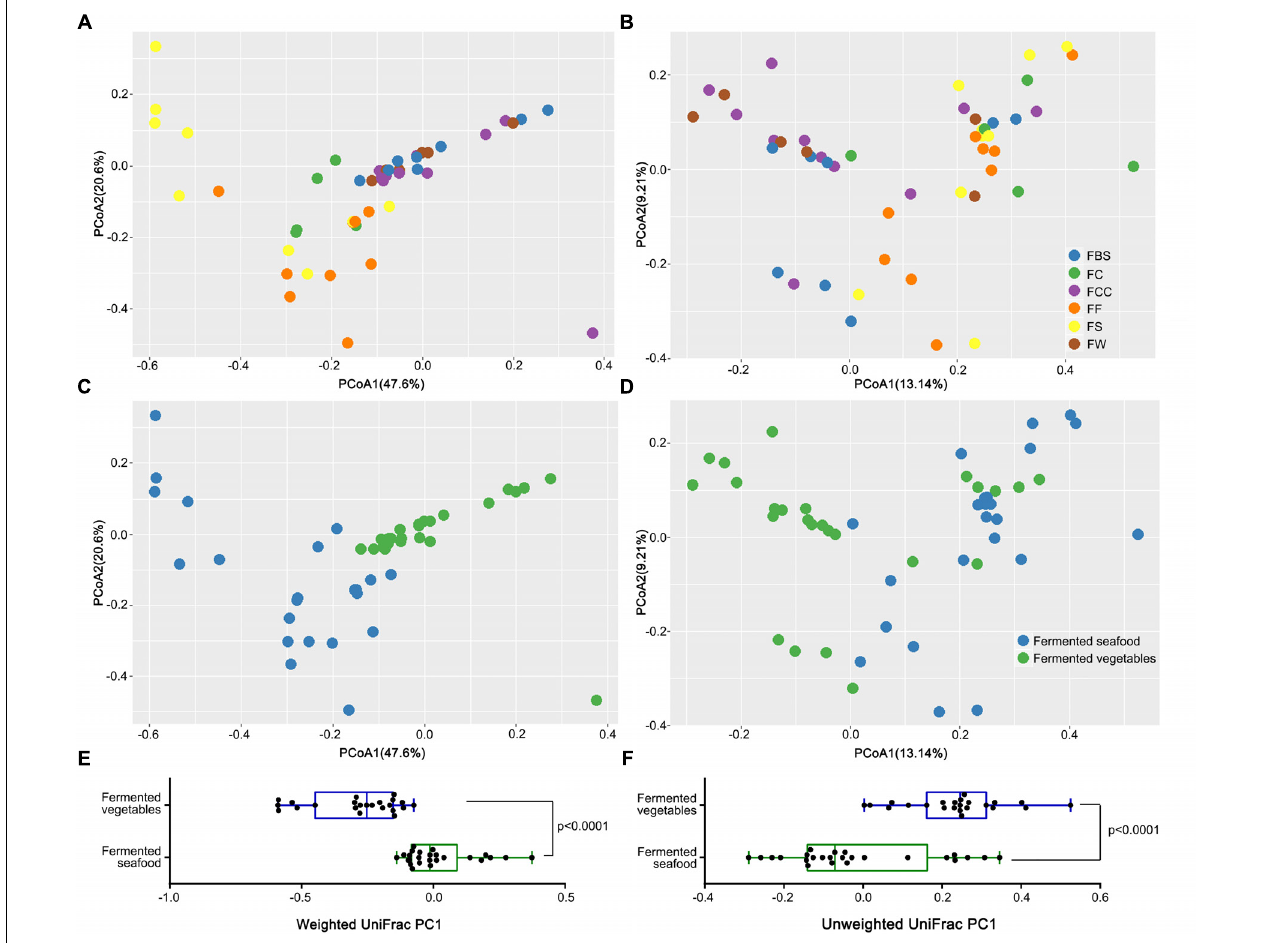
FIGURE 2 | Principal coordinate analysis (PCoA) was used to evaluate the similarity between samples using the UniFrac distance. The UniFrac distance can be divided into unweighted (B,D) and weighted (A,C) . The former only considers whether an OTU exists in the sample or not, and the latter takes into account the phylogenetic relationship among community members and their abundance in the samples. The weighted UniFrac PC1 (E) and unweighted UniFrac PC1 (F) were used to make box plots respectively to compare the differences between fermented vegetables and fermented seafood. Each point represents the composition of the microbiota of one